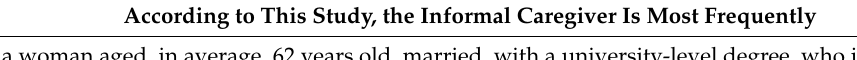
Table 2. Typical profile of the informal caregiver.